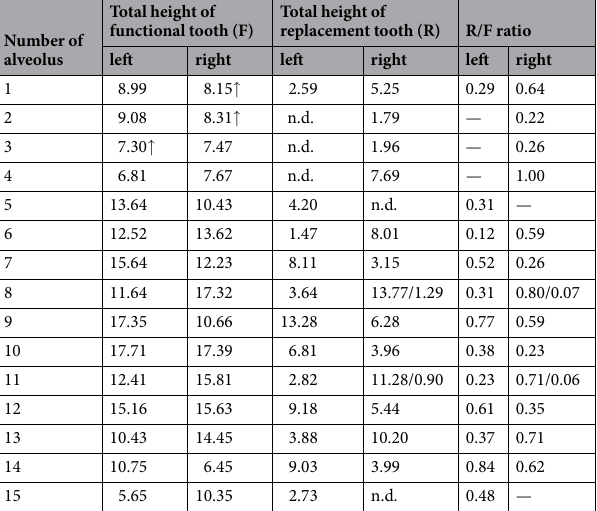
Table 5. Tooth height and the R/F ratio in the lower jaw of IVPP V12738 n.d. = not developed. All measurements in mm.